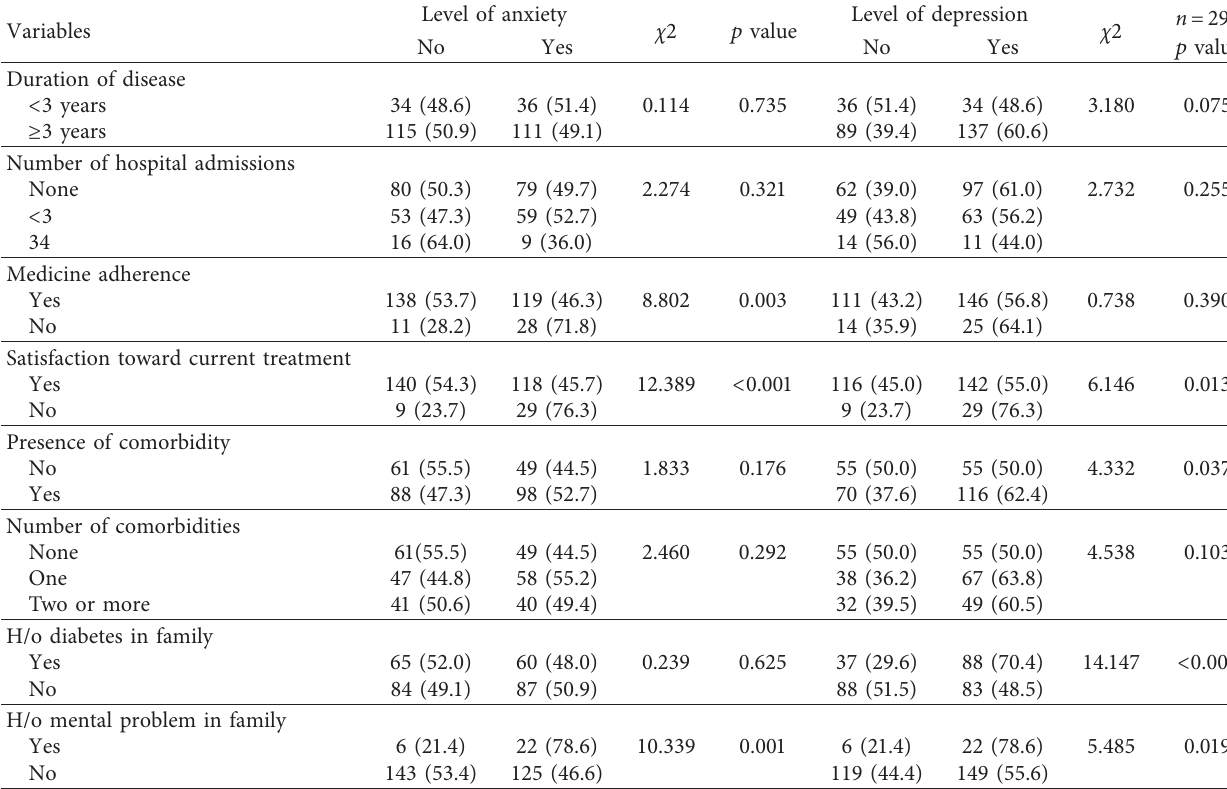
Table 5: Association between anxiety and depression with selected disease-related variables of patients.